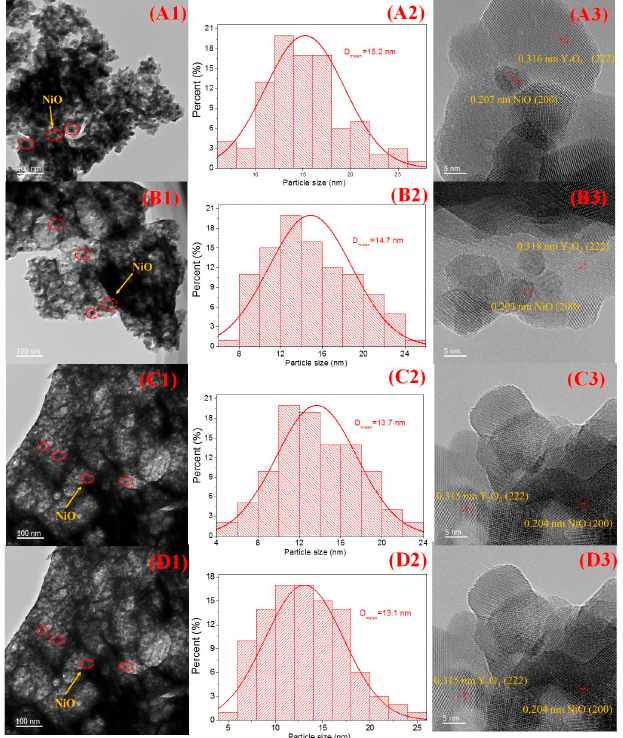
Figure 6. TEM images ( A1 , B1, C1, D1 ), particle size distribution ( A2, B2, C2, D2 ) and HRTEM images ( A3, B3, C3, D3 ) of the freshly calcined catalysts. ( A1 – A3 ) 5Ni/Y 2 O 3 , ( B1 – B3 ) 5Ni/Ce 0.1 Y 0.9 O x , ( C1 – C3 ) 5Ni/Zr 0.1 Y 0.9 O x , ( D1 – D3 ) 5Ni/Al 0.1 Y 0.9 O x .